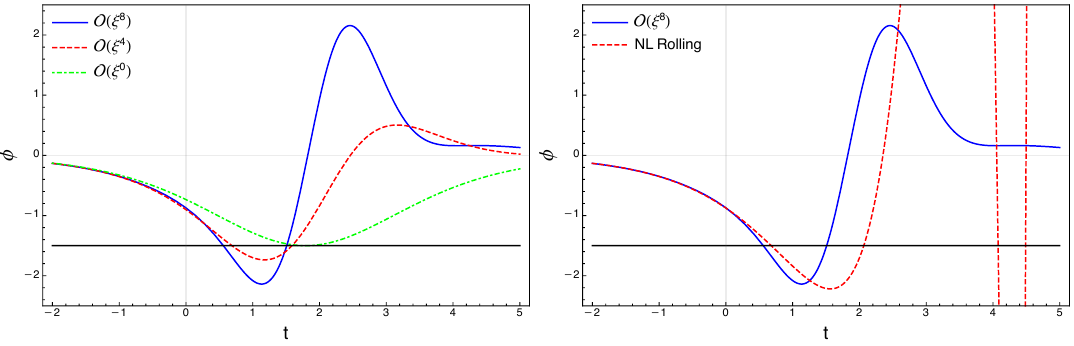
Figure 3 . In both plots ξ = 0 . 4 . Left: the rolling solution (4.23) to orders O ( ξ 4 i ) and O ( ξ 8 ) , shown together with the rolling in the local theory. Right: the rolling solution to order O ( ξ 8 ) compared to the nonlocal theory rolling based on (4.4), including b φ = − 3 / 2 is marked with straight black